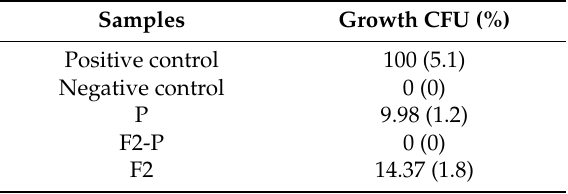
Table 3. Average colony forming unit (CFU %) ± standard deviation (SD) for KSL-W peptide-loaded